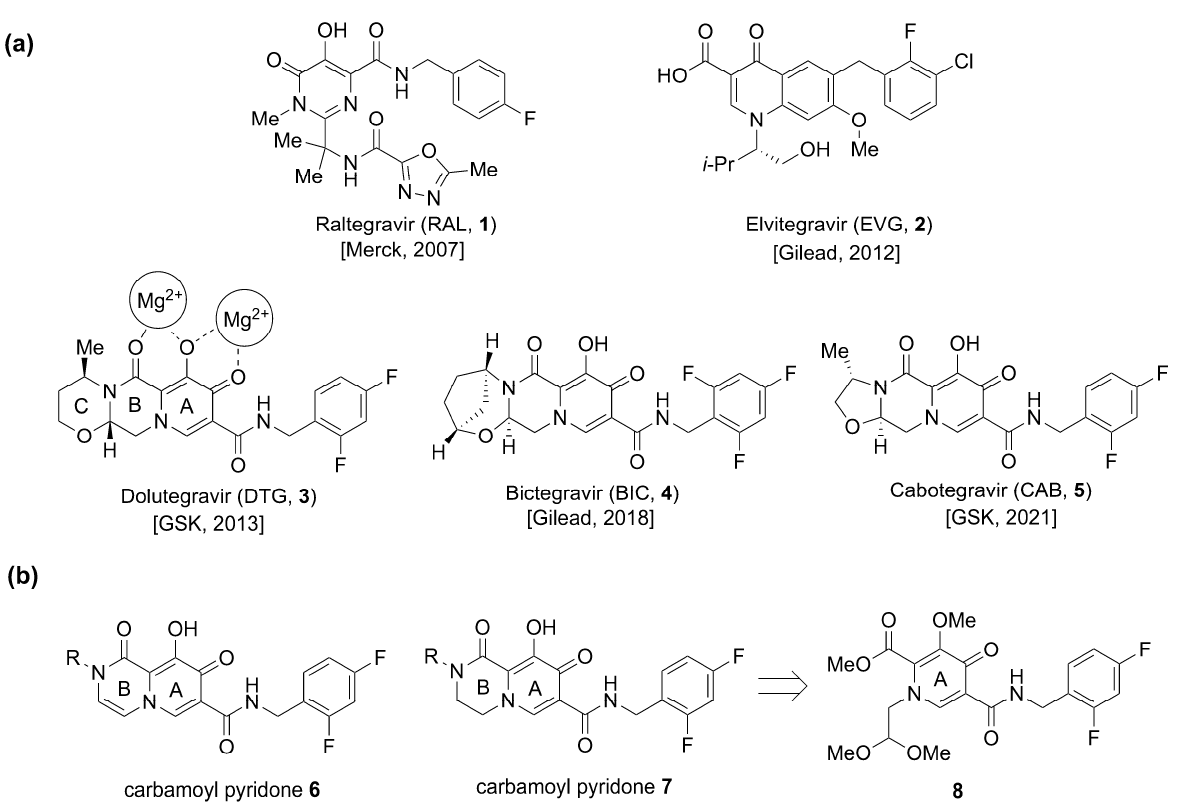
Figure 1. ( a ) FDA-approved INSTIs 1 – 5 and mode of metal chelation 3 . ( b ) Structures of bivalent metal-chelating carbamoyl pyridones 6 and 7 and the monocyclic synthetic precursor 8 .